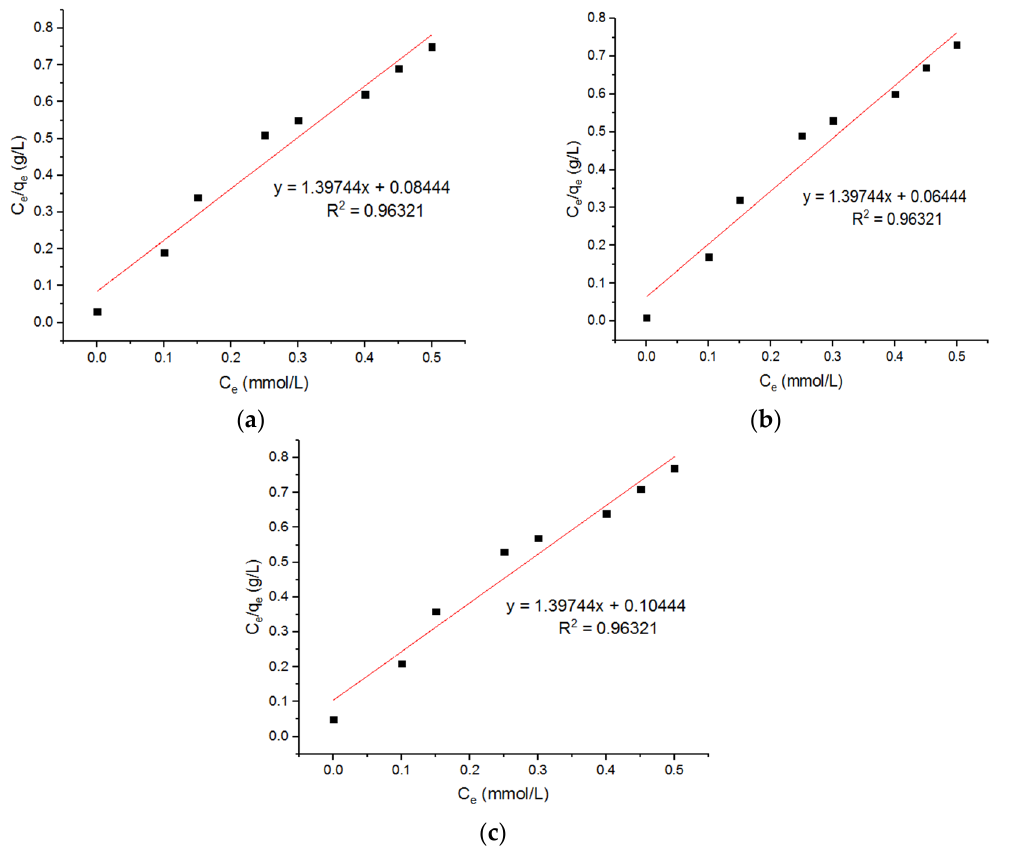
Figure 15. Langmuir plots for adsorption of Pb 2+ onto MgFe 2 O 4 -NH 2 NPs pre-functionalization-calcined at ( a ) 500 °C, ( b ) 600 °C, and ( c ) 700 °C.